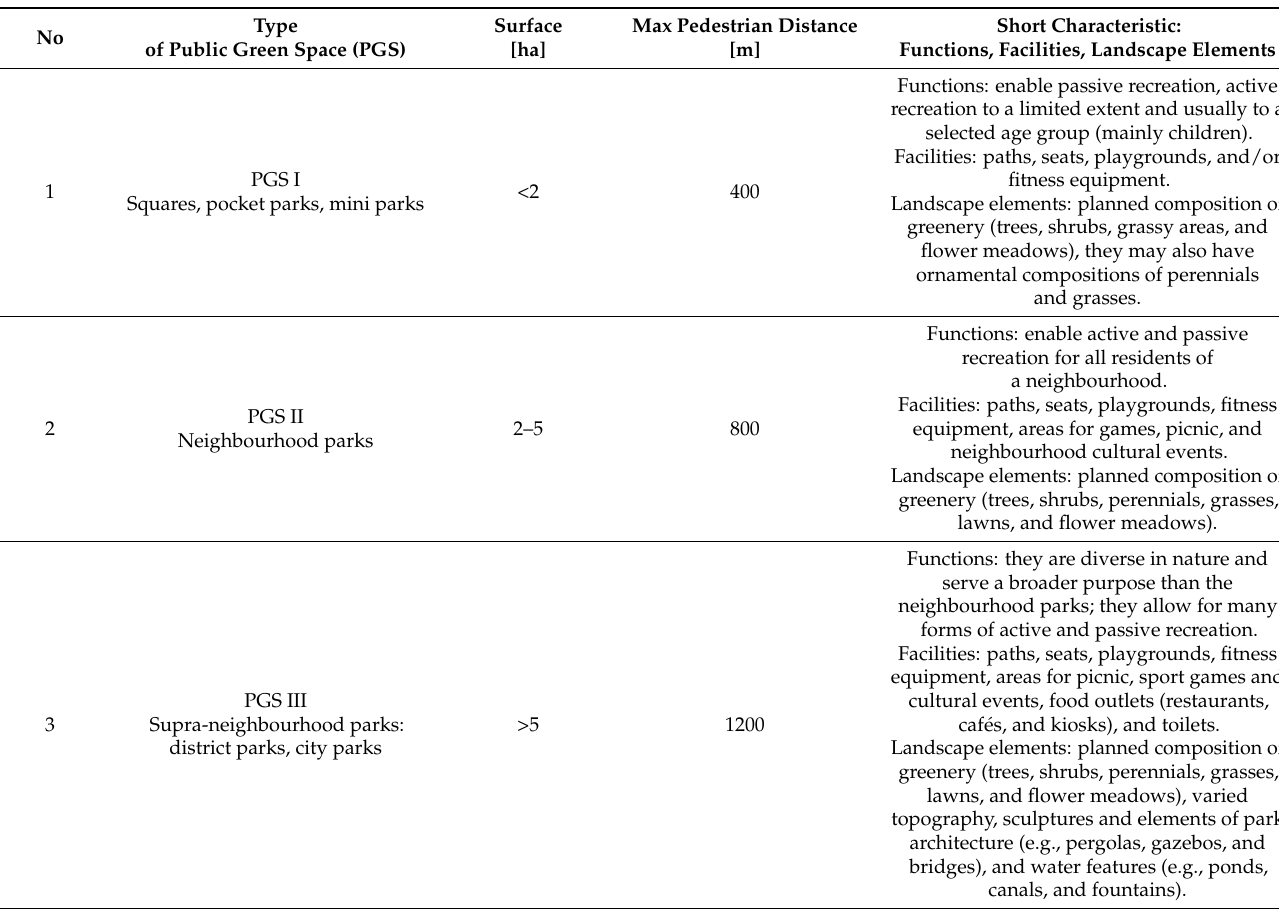
Table 2. Hierarchical structure of public green spaces (PGSs) and maximum walking distances in accordance with the PGS accessibility standards proposed for